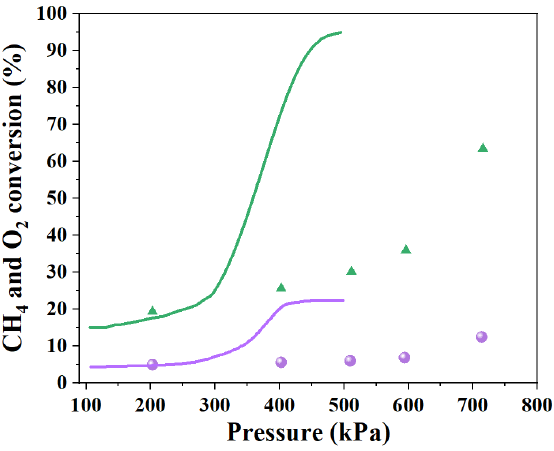
Figure 15. CH 4 ( ● , purple line) and O 2 ( ▲ , green line) experimental conversion and model predic- Figure 15. CH 4 ( • , purple line) and O 2 ( (cid:78) , green line) experimental conversion and model prediction tion (lines) [93]. Reaction conditions were 712 °C, CH 4 /O 2 molar ratio of 4 and spatial time equal to 1 (lines) [93]. Reaction conditions were 712 ◦ C, CH 4 /O 2 molar ratio of 4 and spatial time equal to kg·s·mol − 1 , using a Sn/Li/MgO catalyst. 1 kg · s · mol − 1 , using a Sn/Li/MgO